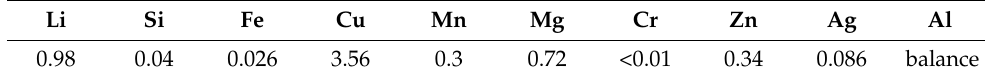
Table 1. Chemical compositions of 2198-T8 Al–Li alloy (mass, wt. %). Li